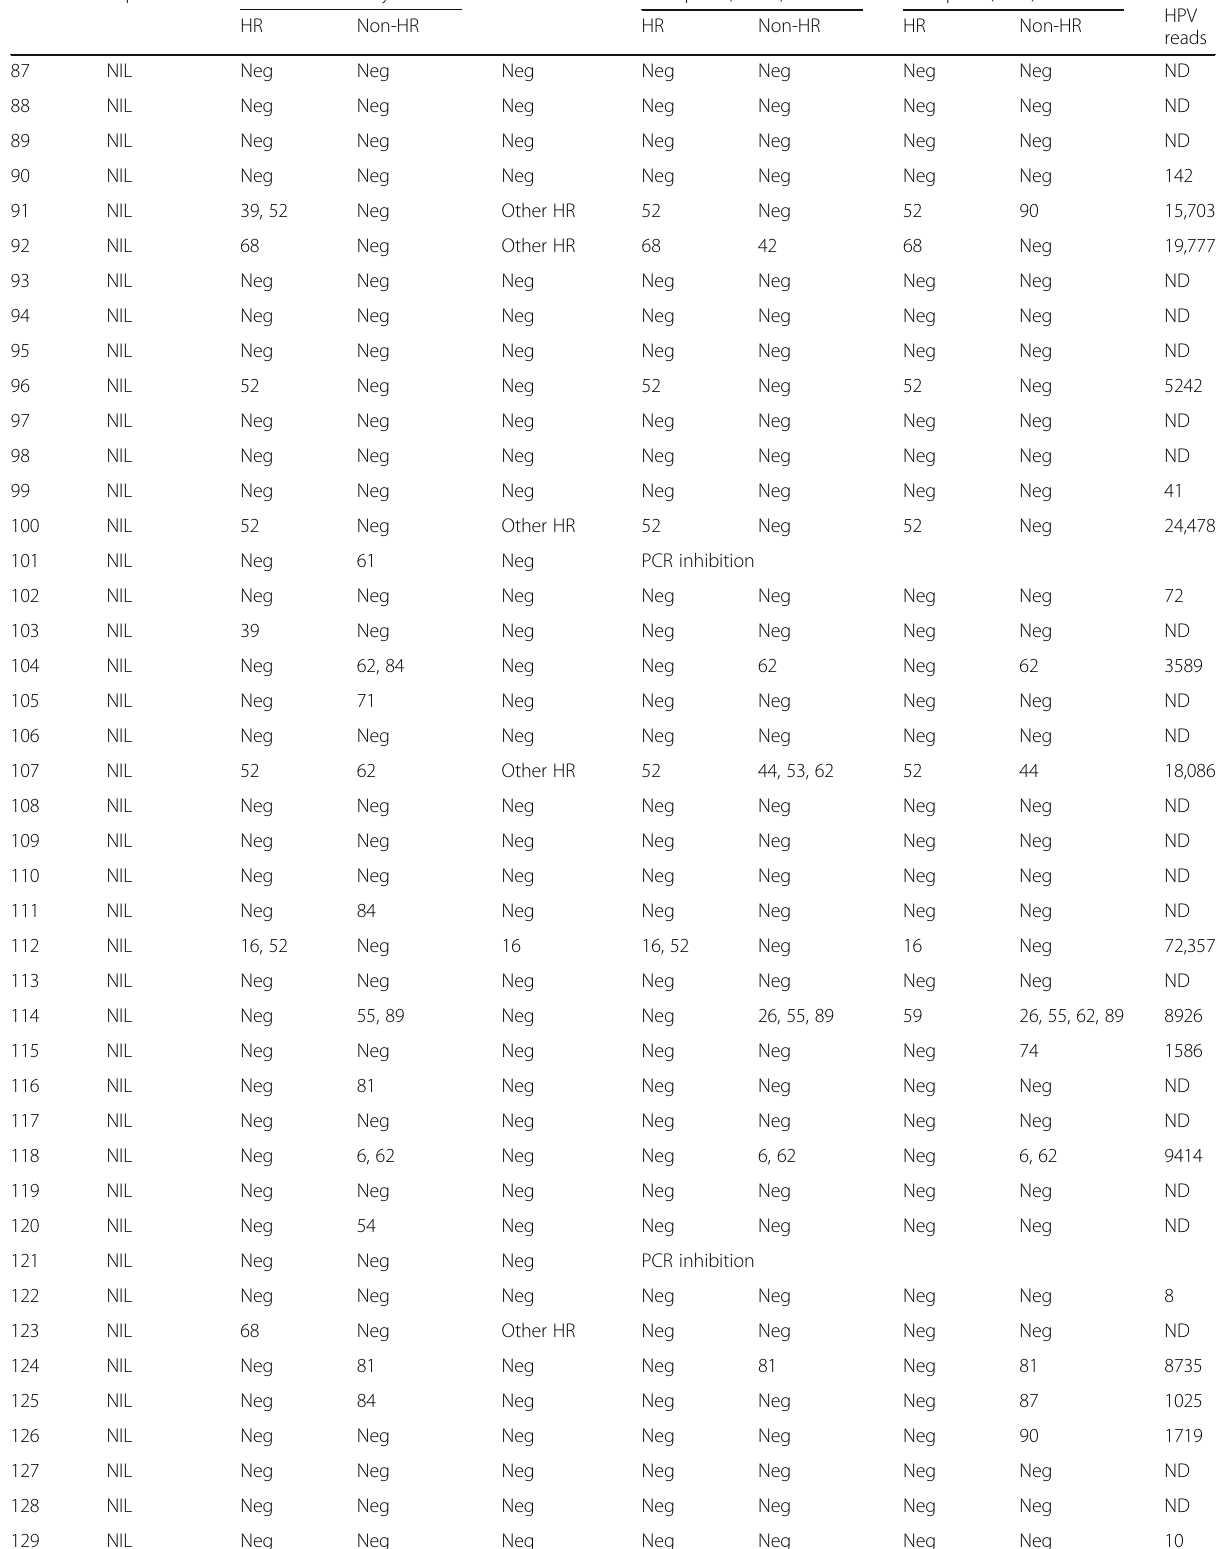
Table 1 Results of Pap smear, cobas HPV Test, Roche Linear Array HPV Genotyping Test, and Nanopore sequencing